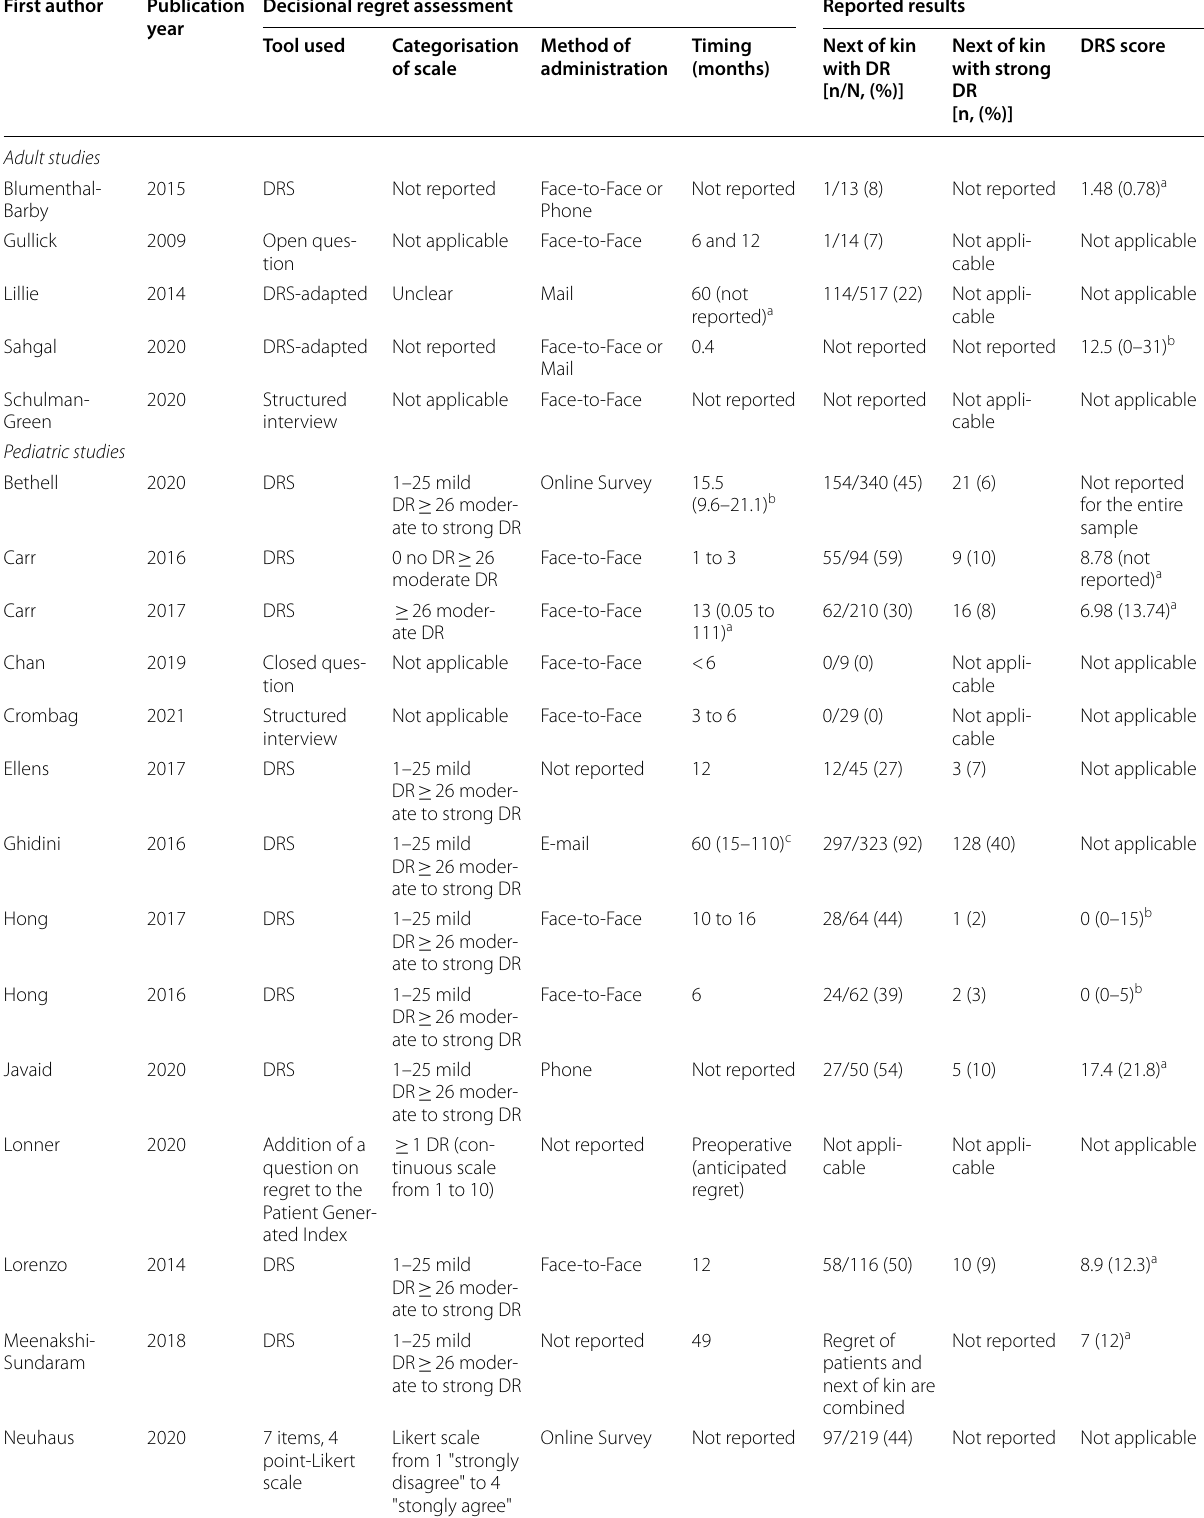
Table 2 Decisional regret assessment tools and reported